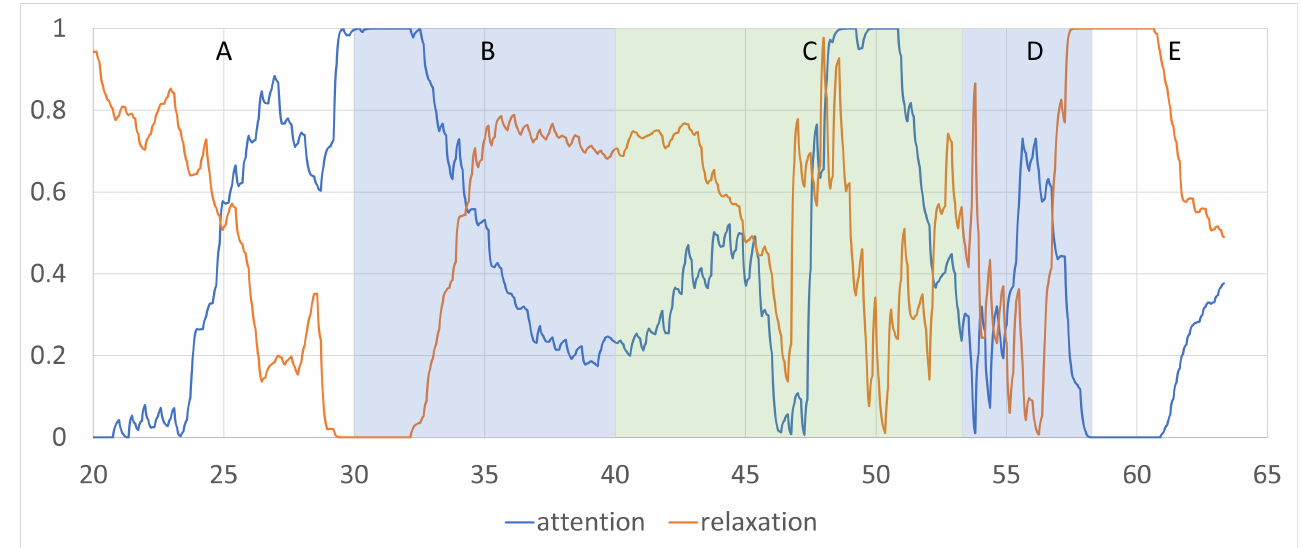
Figure 6. Brainwave recordings interpreted by Looxid Link into two stages (attention and relaxation) of a 33-year-old woman during the whole session divided into three (B, C, and D) separate